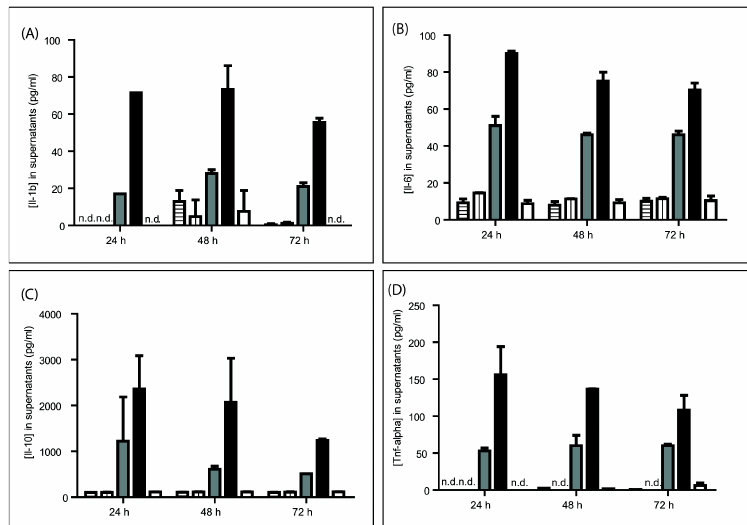
Figure 1. Effect of Griffithsin (GRFT) on the secretion of some mediators of the immune response. Supernatants were collected from mouse peripheral blood mononuclear cell (mPBMC) cultures treated with 1 and 4 μM GRFT (horizontal and vertical lines, respectively), 0.37 and 1 μM Concanavalin A (ConA; grey and black, respectively) and phosphate-buffered saline (PBS; white) for 24, 48, and 72 h. Interleukin (IL) 1 beta (1b) ( A ); IL 6 ( B ); IL 10 ( C ); and tumor necrosis factor alpha (TNF- α ) ( D ) amounts in the supernatants were assessed by enzyme-linked immunosorbent assay (ELISA).